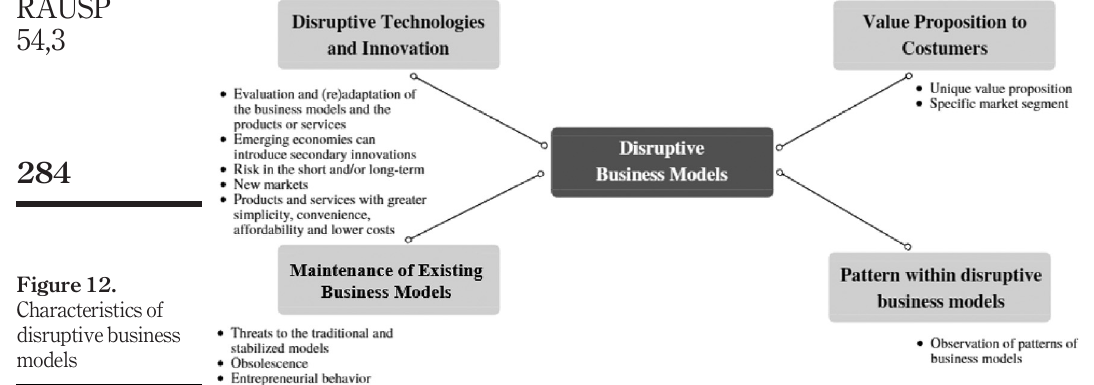
Figure 12. Characteristics of disruptive business